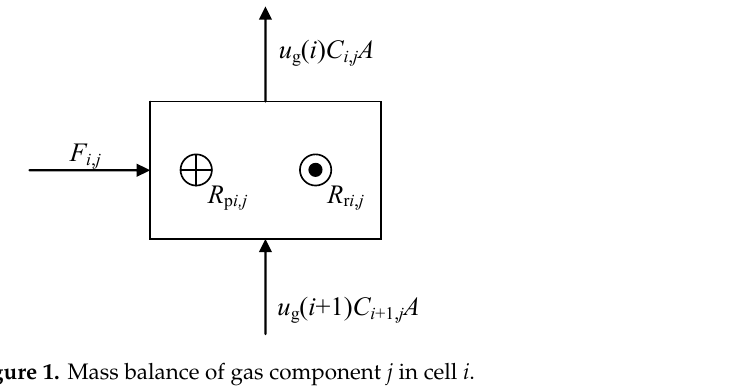
Figure 1. Mass balance of gas component j in cell i .